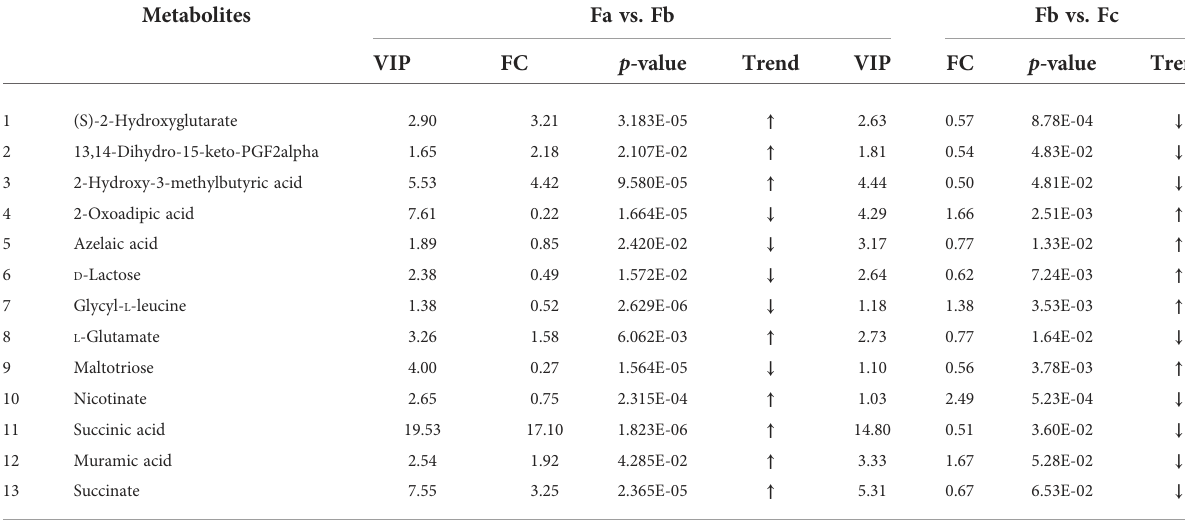
TABLE 2 Differentially expressed metabolites and their variation trend according to variable importance in projection (VIP) values.